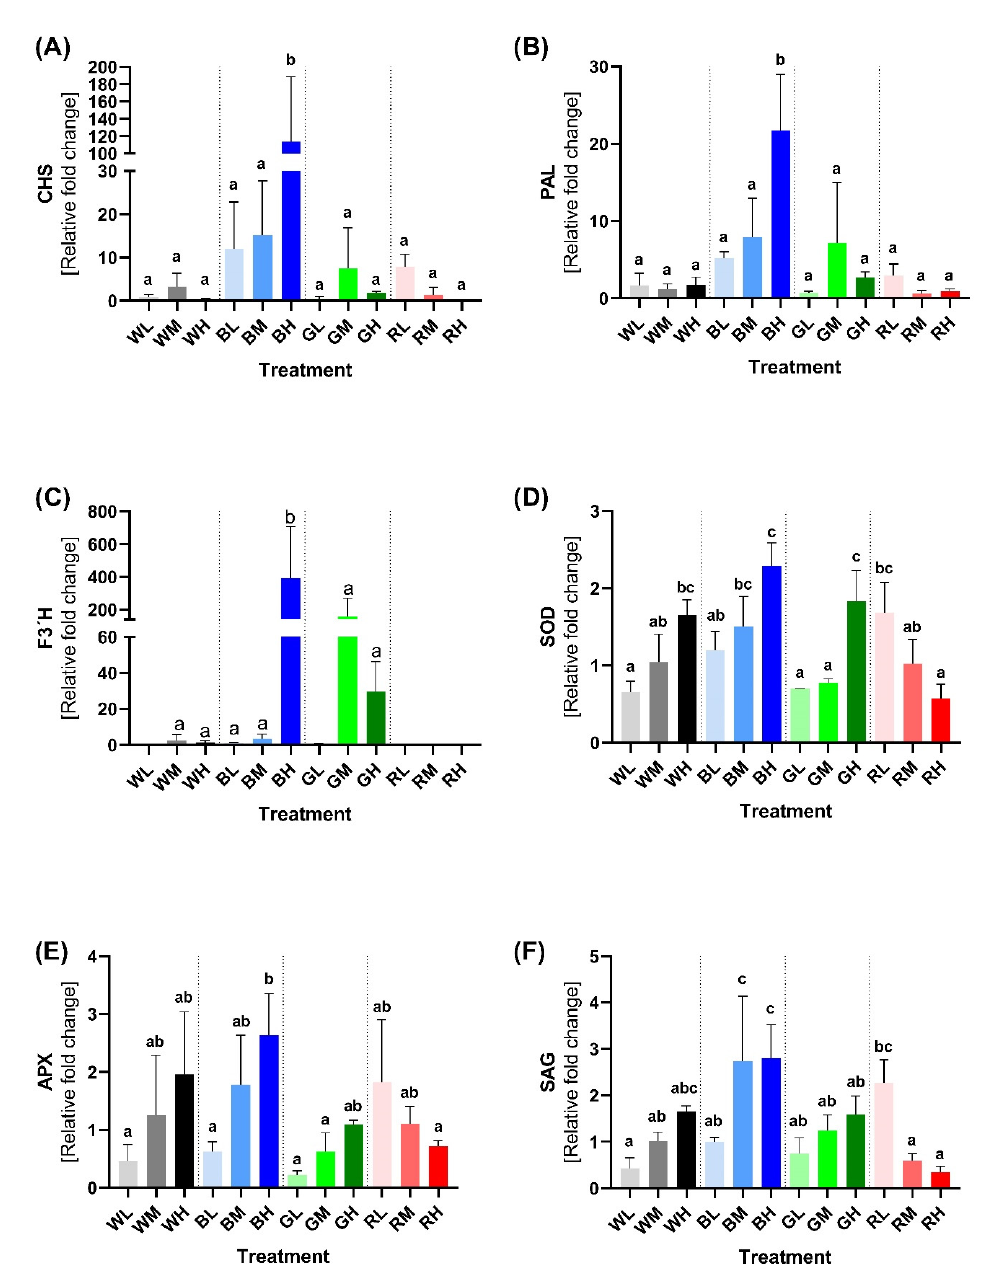
Figure 8. Results of RT-qPCR analysis of selected genes involved in the production of PheCs, antioxidant enzymes, and senescence in Hordeum vulgare L. cv. Bojos acclimated to light conditions varying in irradiance and spectral qualities. Specifications of light treatments: W (white), B (blue), R (red), G (green), L (low irradiance, 100 µmol m − 2 s − 1 ), M (medium irradiance, 200 µmol m − 2 s 1 ), and H (high irradiance, 400 µmol m − 2 s − 1 ); ( A )— CHS (chalcone synthase, EC 2.3.1.74), ( B )— PAL (phenylalanine ammonium lyase; EC 4.3.1.24), ( C )— F3 ′ H (flavonoid 3 ′ hydroxylase; EC 1.14.14.82), ( D )— SOD (superoxide dismutase; EC 1.15.1.1), ( E )— APX (ascorbate peroxidase; EC 1.11.1.11), and ( F )— SAG (senescence associated gene 12). Treatments marked above with same letters did not significantly differ based on Tukey's post-hoc test.